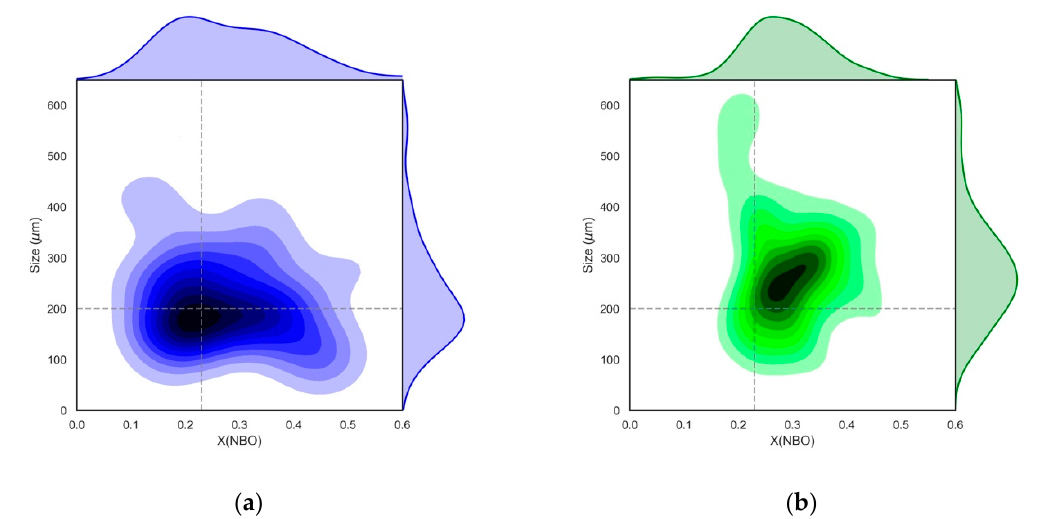
Figure 2. Bivariate density plots of size and X(NBO) for ( a ) ‘poor’ glasses and ( b ) ‘good’ glasses (as defined in the text). Darker shading represents a higher spatial density of glasses for that region of the plot. Univariate distribution estimates for size and X(NBO) are shown on the right and top edges of each figure. Dashed lines indicate a median cutoff size of ≥ 200 μ m and an X(NBO) value of ≥ 0.23. Data in both figures are from [6–10] and Table 1.